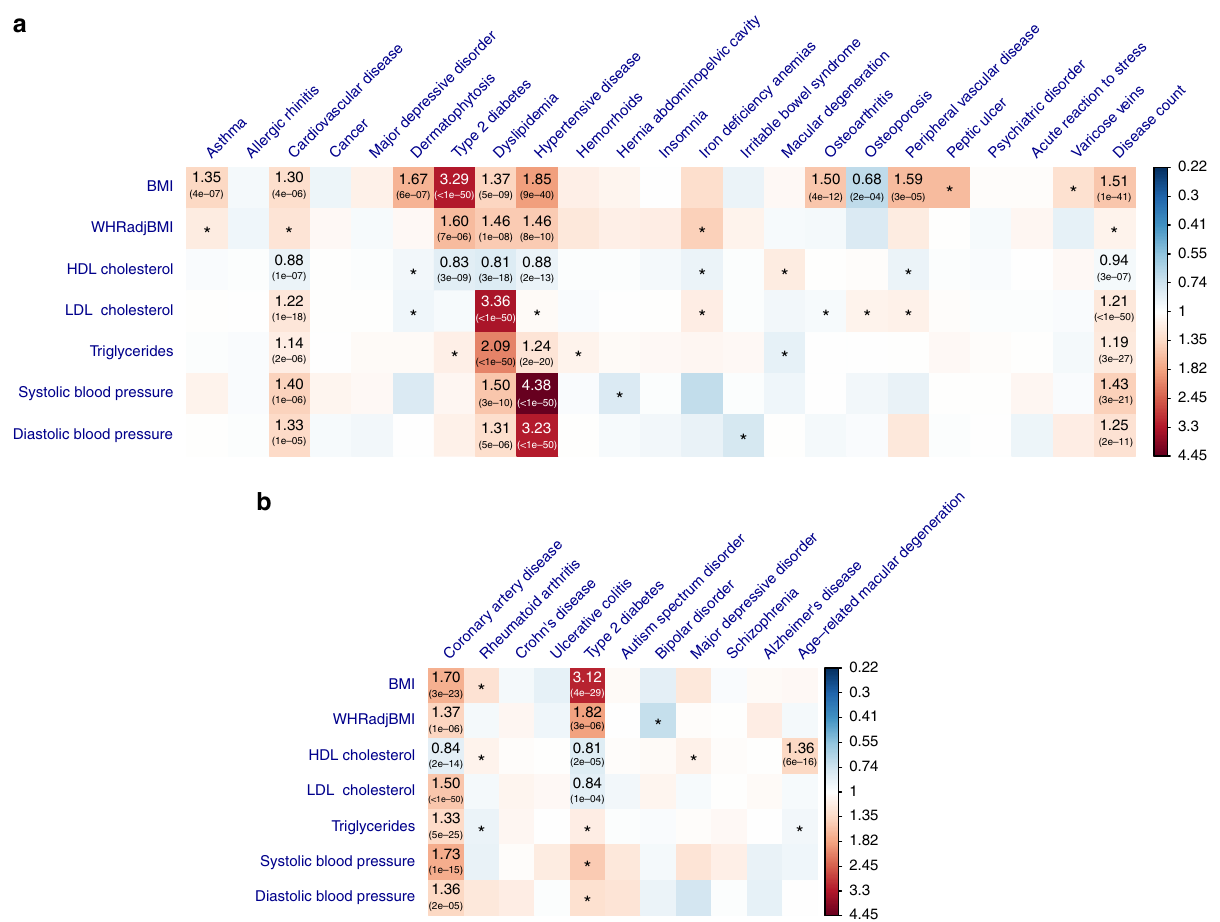
Fig. 2 Putative causal associations between seven modi fi able risk factors and common diseases. Shown are the results from GSMR analyses with disease data a from a meta-analysis of two community-based studies (GERA and UKB) and b from published independent case – control studies. Colors represent the effect sizes (as measured by odds ratios, ORs) of risk factors on diseases, red for risk effects and blue for protective effects. The signi fi cant effects after correcting for 231 tests ( P GSMR < 2.2 × 10 − 4 ) are labeled with ORs ( P -values). The nominally signi fi cant effects ( P GSMR < 0.05) are labeled with “ *